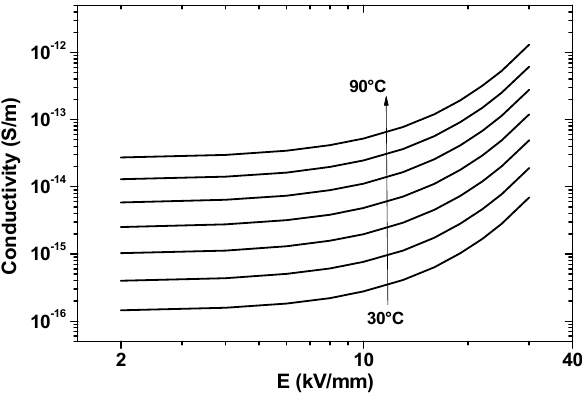
Figure 8. Conductivity vs. field and temperature (in 10 °C step) obtained from the model.